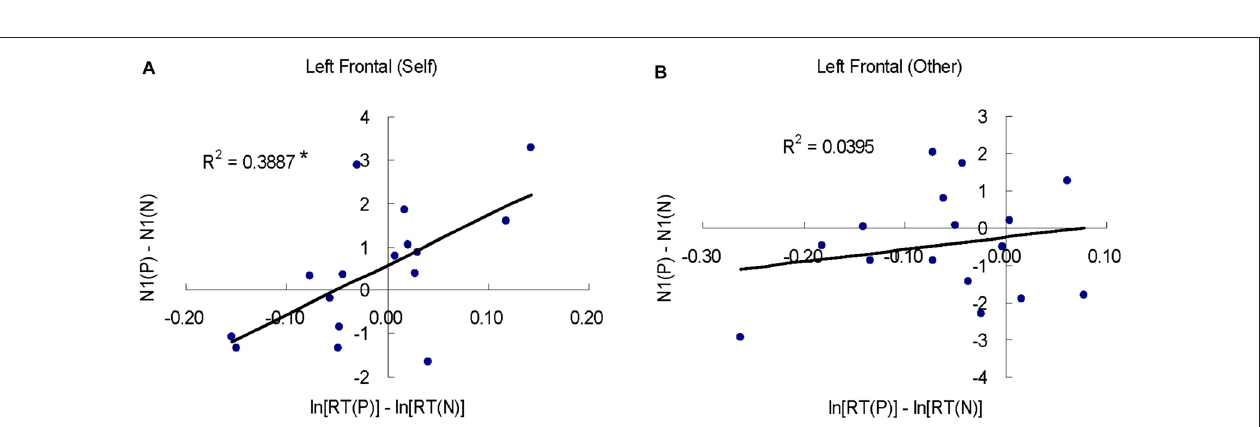
FIGURE 6 | The correlations between behavioral RT and N1. (A,B) Indicate the correlation between RT and N1 based on the emotional valence effect in the self- and other-referential conditions. P indicates the positive condition and N is for the negative condition. ∗ p < 0.05, Bonferroni corrected.